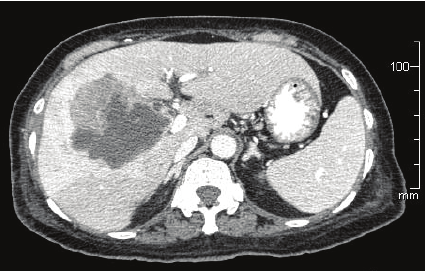
Figure 1: An 8.6 cm right-sided liver mass with associated abscess.